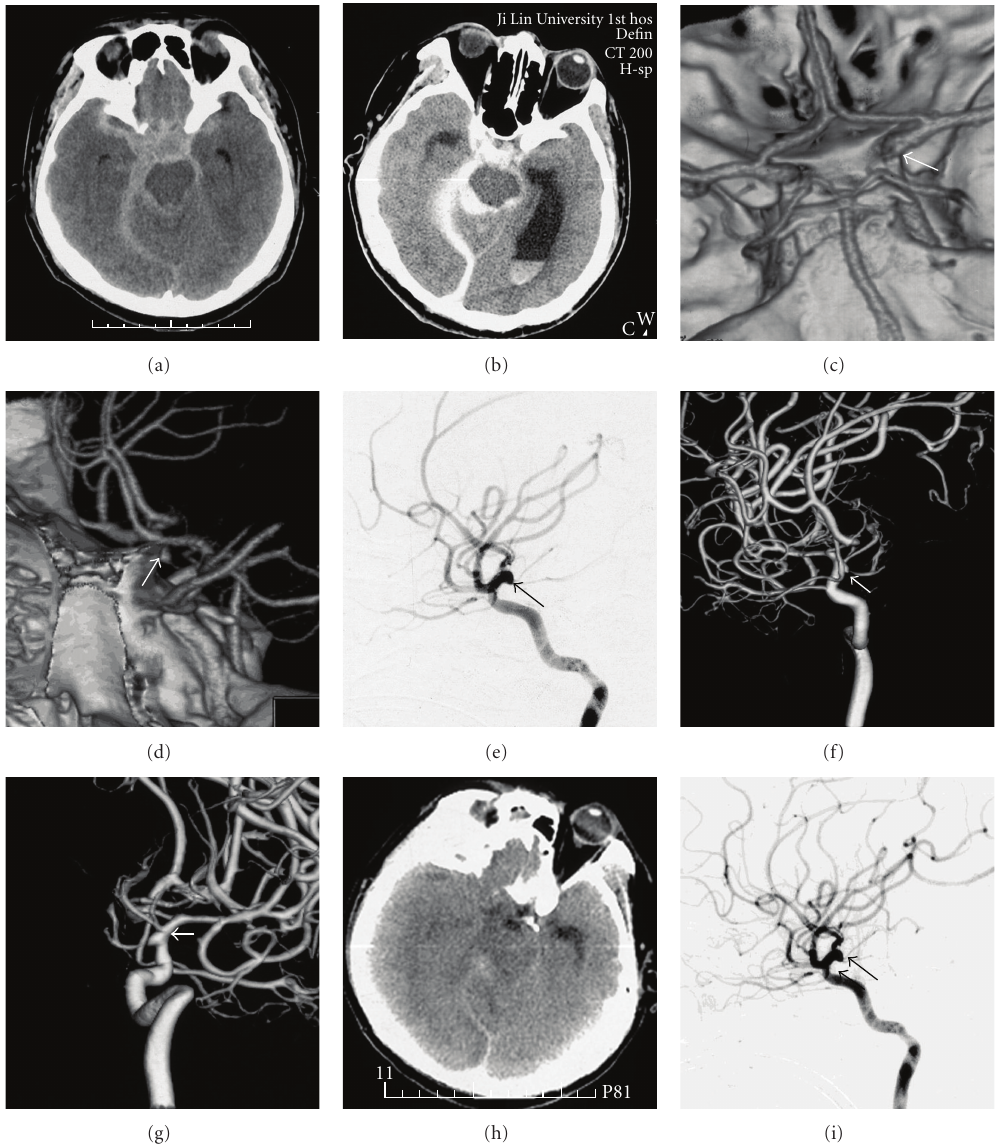
Figure 1: Diagnosis of ruptured ID of the PCo-A. (a, b) Two SAH images detected at an interval of 9 hours show that the bleeding points in both episodes of hemorrhage were centered around the origin of the right posterior communicating artery and that the suprasellar cistern, sylvian cistern, ambient cistern, and tentorial margin were involved. Blood entry into the ventricles and the presence of ventriculomegaly were seen in (b). (c, d) Head CTA showed that a funnel-shaped expansion with a diameter of less than 3mm occurred at the origin of the right posterior communicating artery and was in conjunction with the thin right posterior communicating artery at its apex (arrow). (e)–(g) The first DSA showed that a funnel-shaped expansion occurred at the origin of the right posterior artery and was in conjunction with the thin right posterior communicating artery at its apex, a finding similar to the results of CTA (arrow). (h) Reexamination by head CT after 20 days of conservative treatment demonstrated that SAH was absorbed and the size of ventricles was normal. (i) The second DSA examination after 20 days of conservative treatment revealed that the funnel-shaped expansion still existed at the origin of the right posterior communicating artery and was in conjunction with the thin posterior communicating artery at its apex, similar to the results obtained by CTA and the first DSA